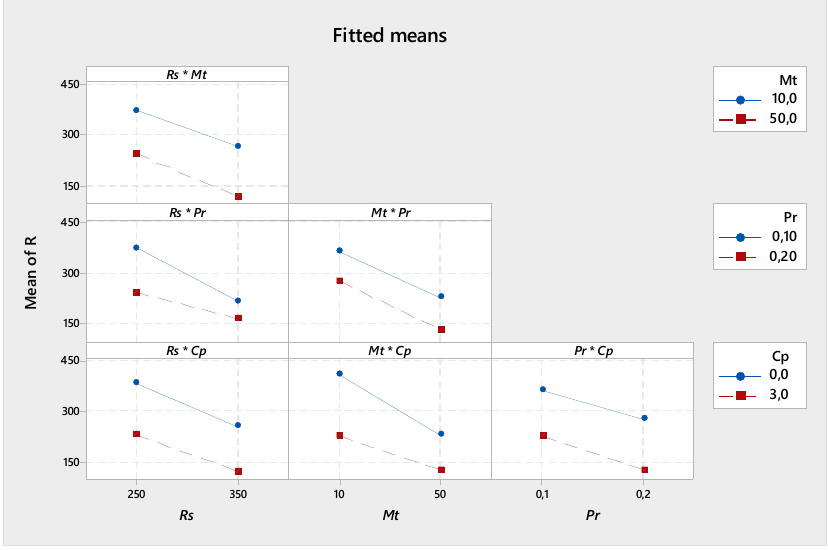
Figure 5. Interactions effects analysis among milling parameters: Rs , Mt , Pr, and Cp.